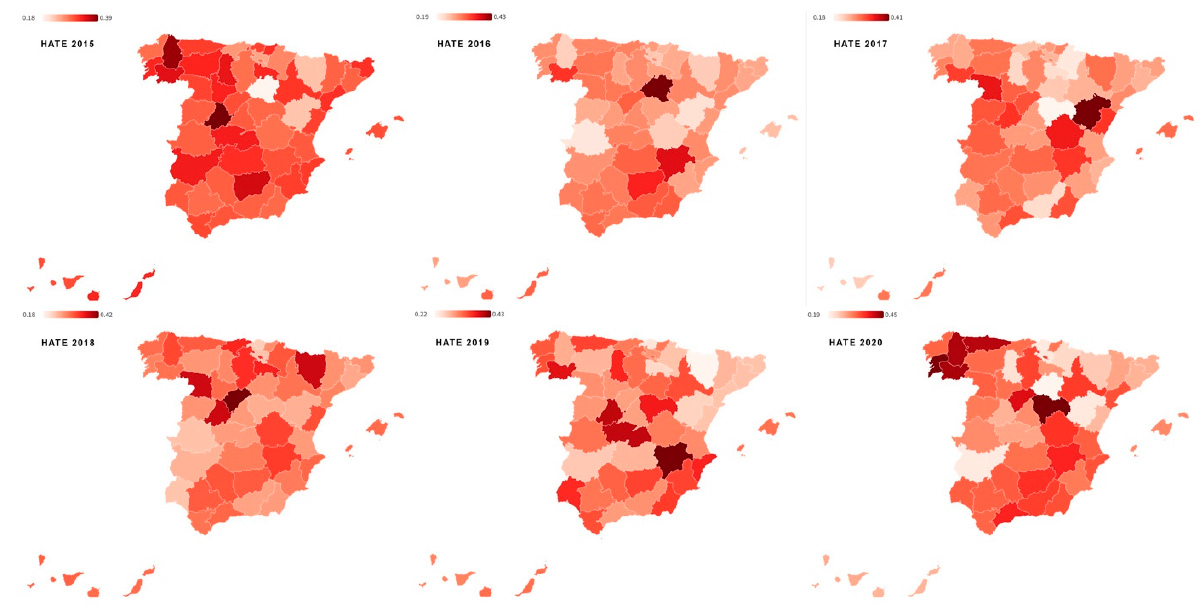
Figure 4. Hate speech total average present on Twitter in Spain. Own elaboration.